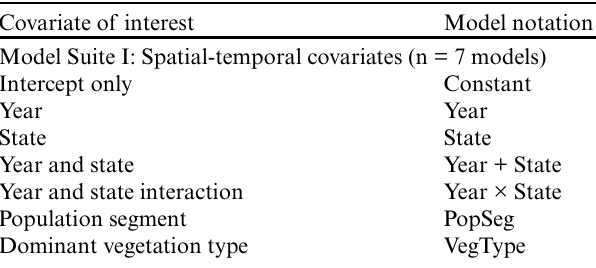
Model Suite III: Vegetation covariates (n = 38 models)